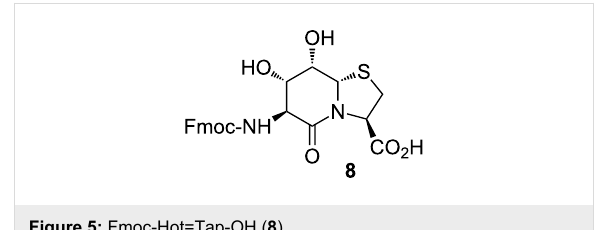
Figure 5: Fmoc-Hot=Tap-OH ( 8